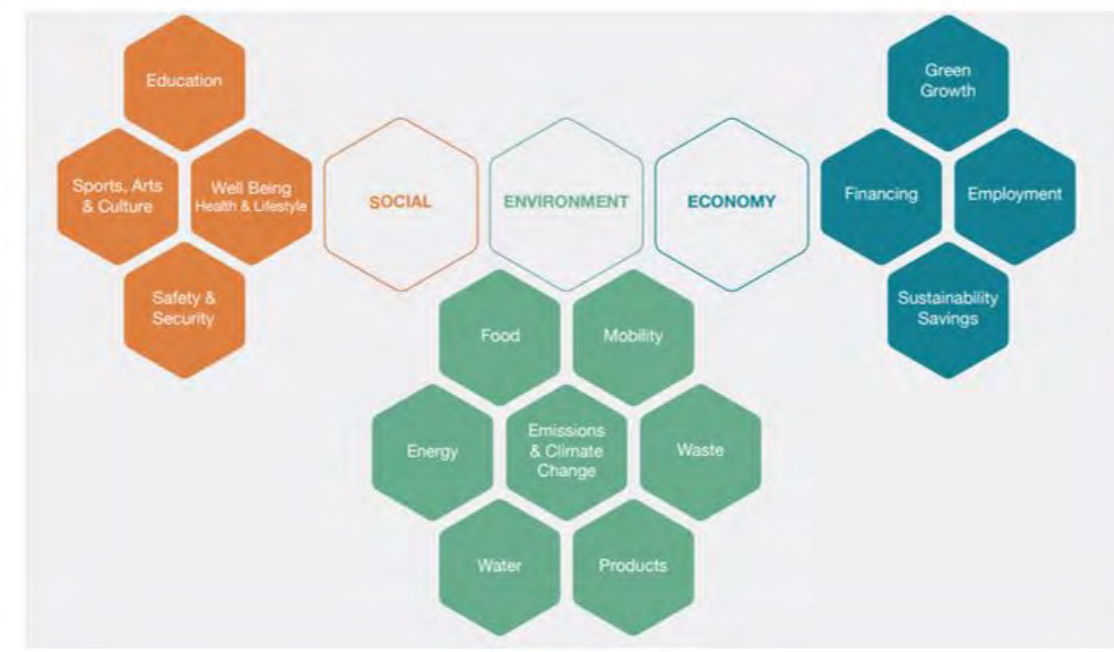
Figure 4. Sustainable principles in thesustainable city in Dubai (Diamond,